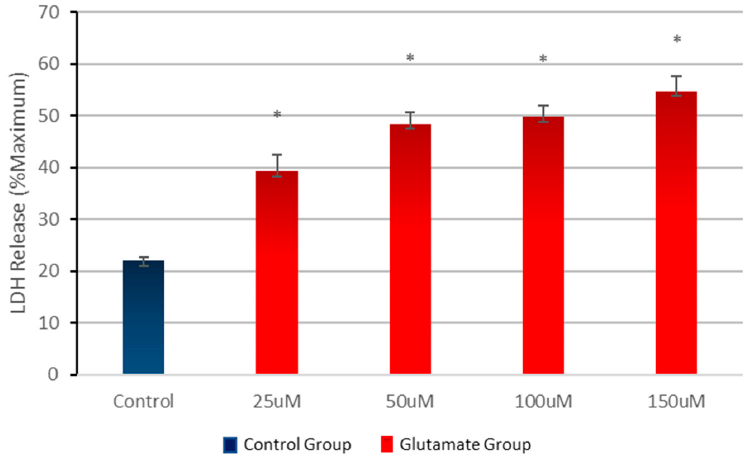
Figure 1. Effects of various concentrations of glutamate on cell mortality . Primary cortical cells were treated with various concentrations of glutamate or in the absence of glutamate (control) for 15 min. Cell mortality was measured after 24 h of treatment. Glutamate causes a significant increase of mortality. Cell mortality is expressed as the mean (±SEM) from three experiments ( n = 3); * p < 0.005 (0–100 mM) compared to untreated control cells.